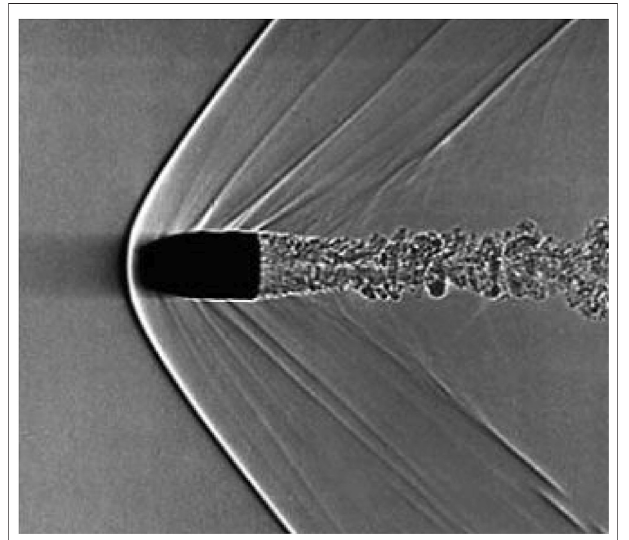
FIGURE 1 | Turbulent fl ow behind a fl ying bullet (the shadowgraph).